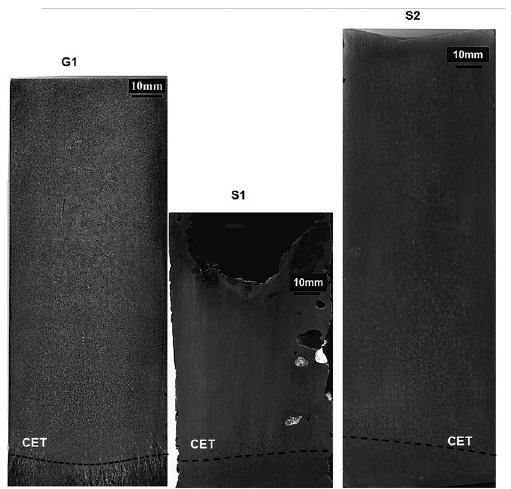
Figure 4: Longitudinal macrostructures of the DS cast iron for the three examined solidification conditions. growth rate values against CET is quite different from that of cooling rate, with very similar values of V found for the different CET positions in the three experiments performed with cast iron.